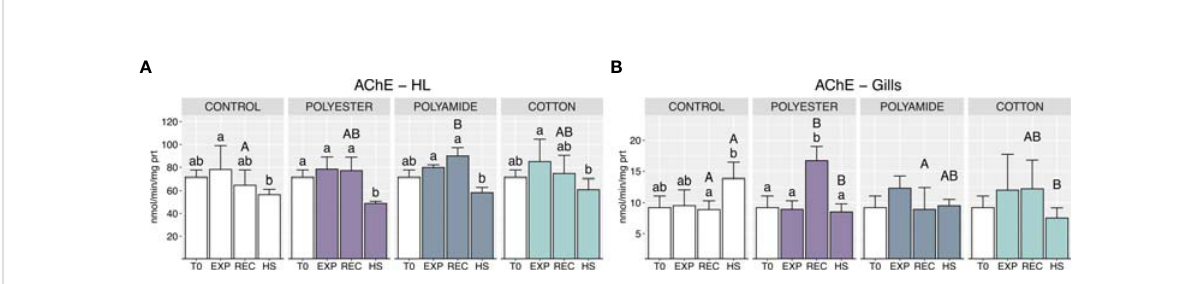
FIGURE 4 Acetylcholinesterase activity in haemolymph (A) and gills (B) in control and polyester, polyamide or cotton-exposed mussels measured at T0 and at the end of each experimental phase (EXP, end of MFs-exposure; REC, recovery after MFs-exposure; HS, heat-stress after the MFs- exposure). Upper case letters highlight differences among treatments within the same experimental phase; lower case letters highlight differences among different experimental phases of the same treatment. Values are given as mean ± SD